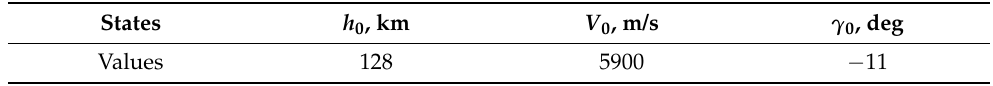
Table 1. Initial conditions of Mars aerocapture. States h 0 ,